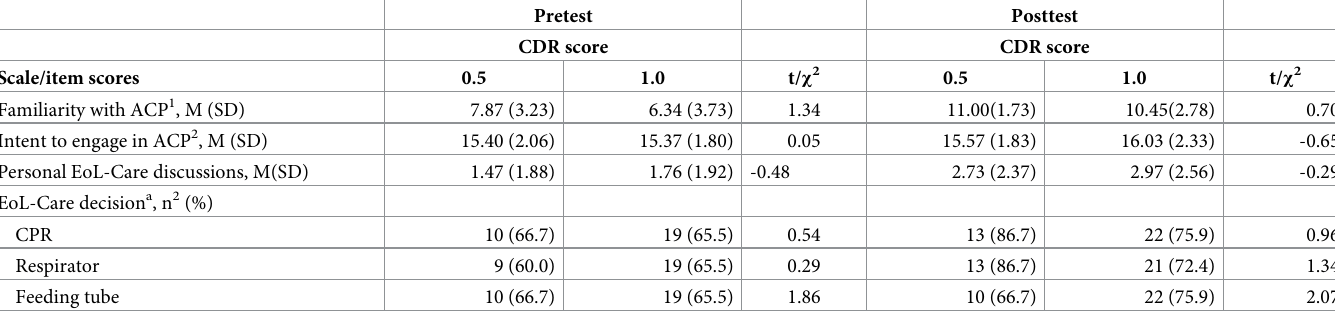
Table 8. Comparisons of pretest/posttest scale scores between FCGs of PWCIs with different